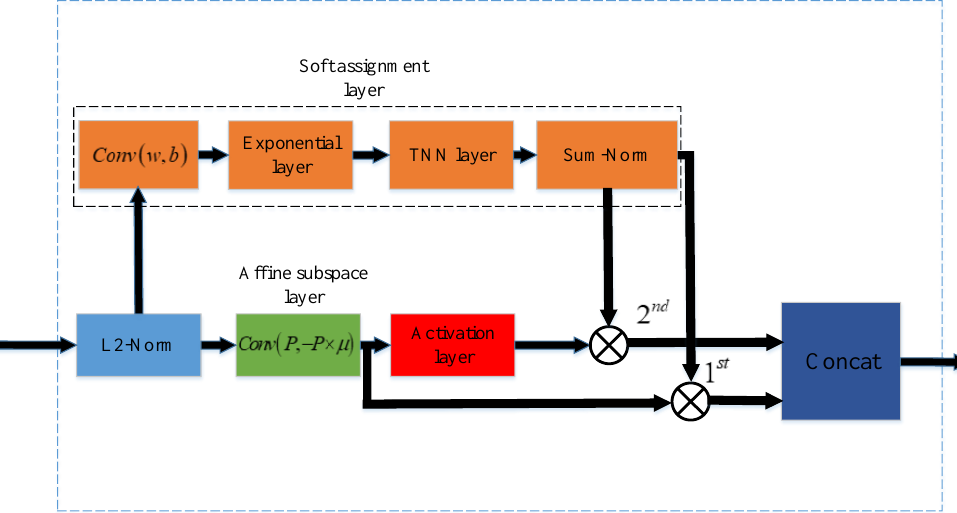
Figure 4. The network architecture of the parameterized LASC layer. The input of the parameterized LASC layer is the standard convolution layer in the convolutional neural network (CNN), which is a D dimensional feature vector. Both the dimensionality of the first-order and second-order LASC statistical information are K × S . Finally, we cascade them.